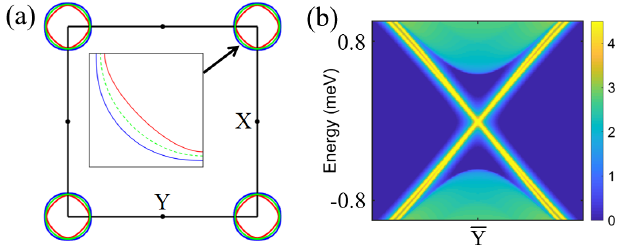
FIG. 10. (a) shows the sign-changed s -wave pairing simulated by the superconducting order in Eq. (G4), with the sign of the superconducting order indicated by red ( þ ) and blue ( − ). The Fermi surfaces are in the same condition as those in Fig. 9(d), and the pairing nodes are labeled by the green color. (b) shows the ¯ Y edge modes around on the (10) boundary, corresponding to the superconducting state in